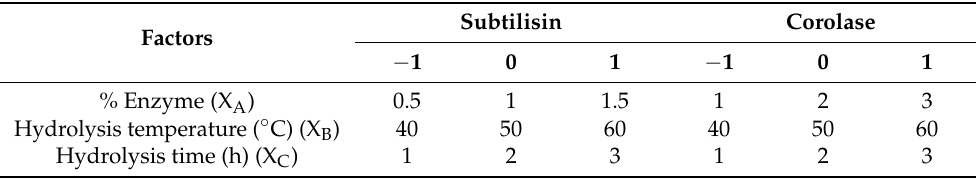
Table 13. Levels for 3 experimental factors for the two experimental